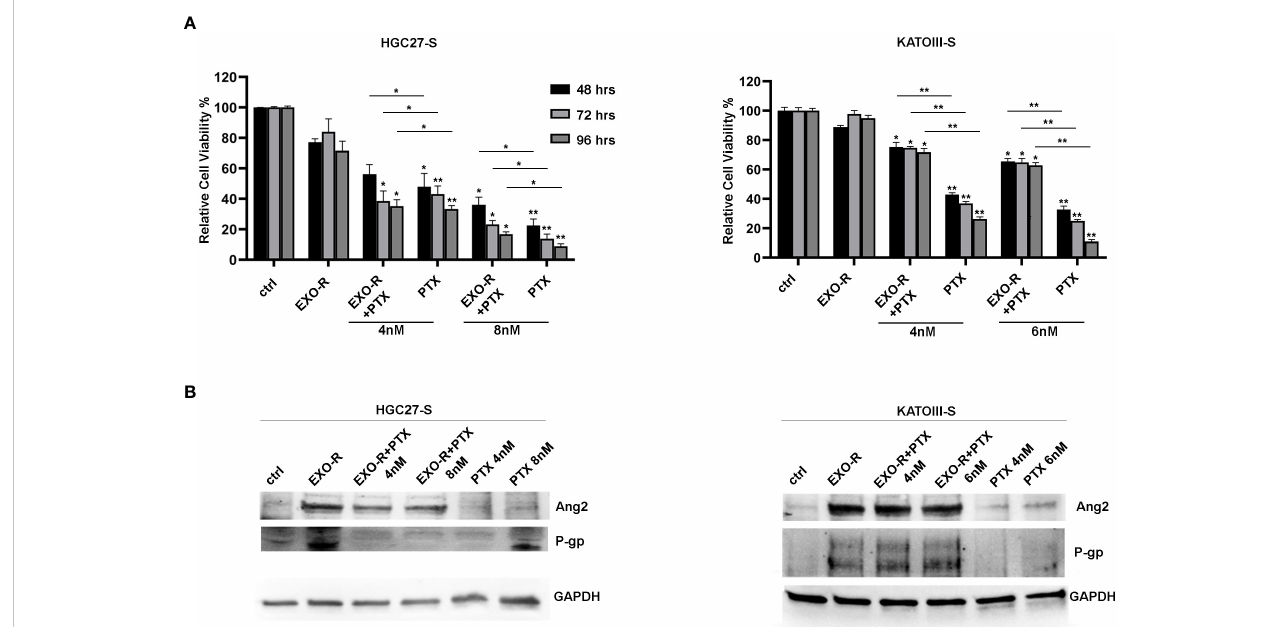
FIGURE 8 Effects of exosomes derived from PTX-resistant cells on PTX-sensitive GC cells. (A) MTS assay performed on HGC27-S and KATOIII-S cell lines treated with exosomes (EXO-R) extracted by HGC27-R and KATOIII-R cells medium respectively. Different PTX concentrations (4 nM and 8 nM for HGC27 and 4 nM and 6 nM for KATOIII) were added for 48, 72, 96 hrs. The percentages of cell viability have been compared to that of untreated cells (100%). Signi fi cance was also calculated between each sample treated with PTX alone and the respective combined PTX+EXO-R treatment. The experiments were performed in triplicate and the mean values ± SD were plotted in the relative graph. *p < 0.05; **p < 0.01; (B) Expression analysis of P-gp and Ang2 proteins in PTX-sensitive GC cells treated with/without EXO-R and with/without PTX as described